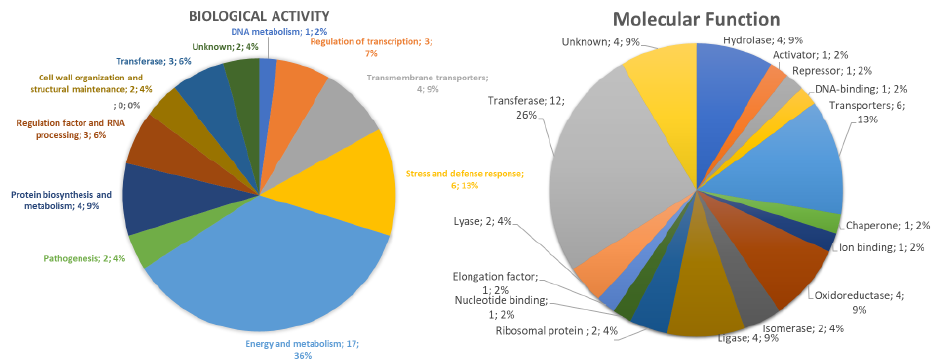
Figure 6. Classification proteins from K. pneumoniae cells identified by LC-ESI-MS/MS analysis. The overlapping proteins (found in both control and treated) were classified based on biological process and molecular function. Table 2. Differentially accumulated proteins identified by